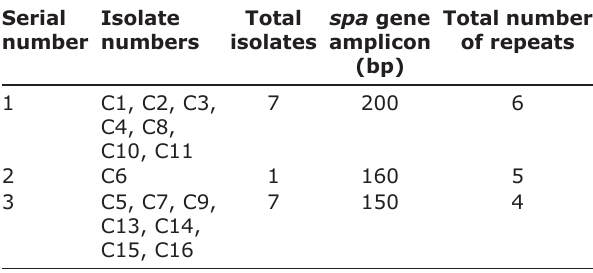
Figure-3: Polymerase chain reaction amplicons of spa gene (X-region) of Staphylococcus aureus isolates from Rathi cattle (R13-R22) with subclinical Table-1: spa gene (X-region) polymorphism in S. aureus isolates from H-F crossbred cattle with subclinical mastitis.